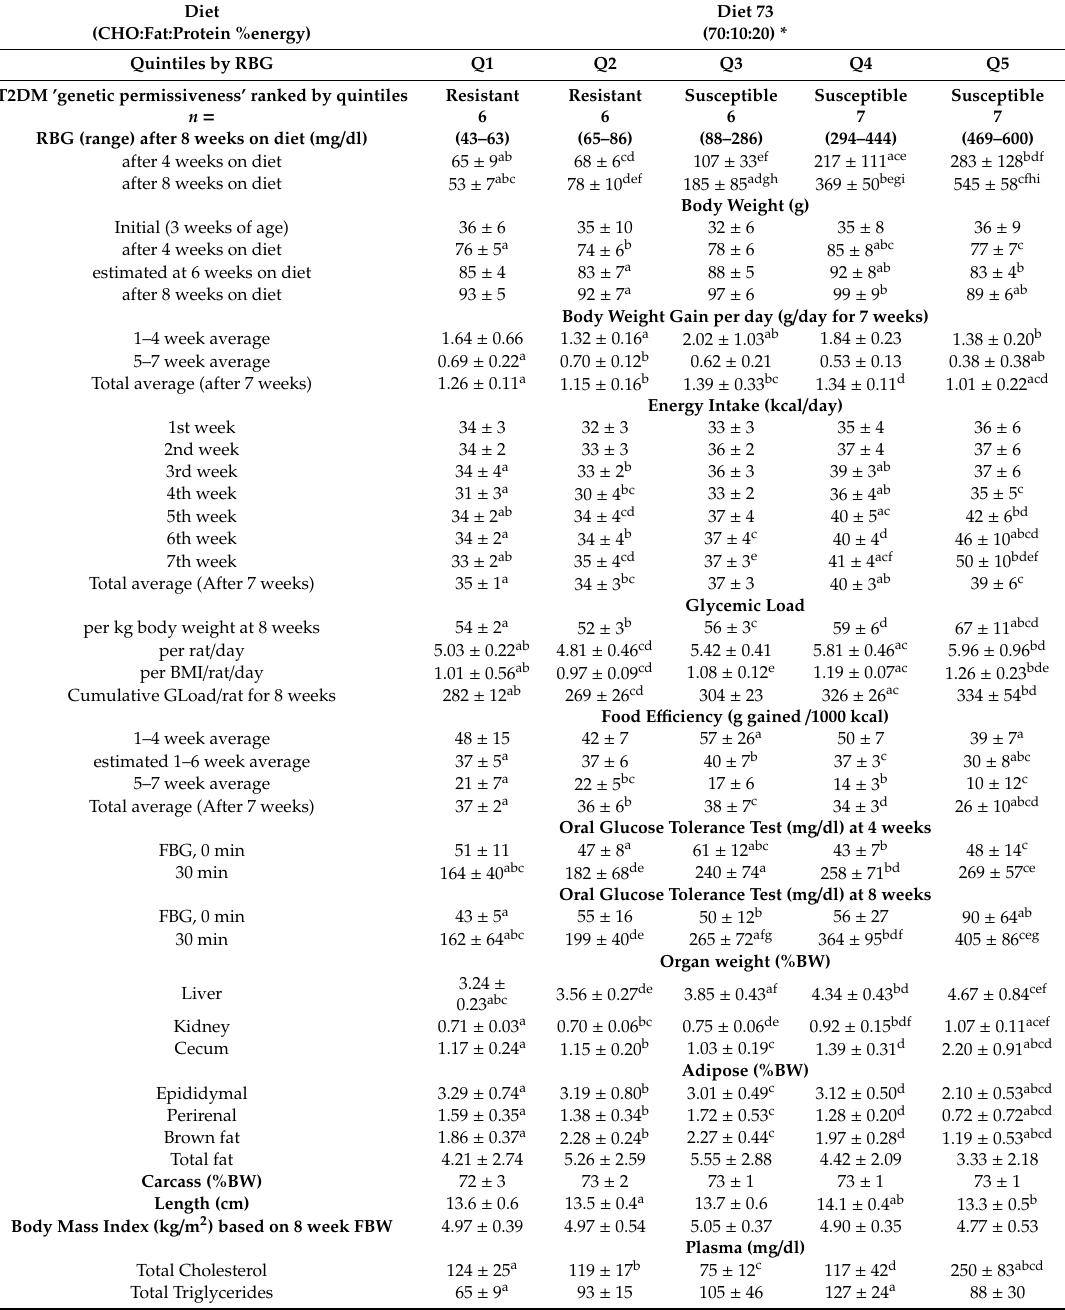
Table 5. (Experiment 3). Quintiles of RBG along with diabetes metagenetic profile for 32 male Nile Rats (3 weeks old) fed semipurified high CHO Diet 73 (70:10:20)* for 8 weeks, then subdivided into ’resistant’ or ’susceptible’ quintiles based on RBG < 75 mg / dl > , respectively (NR Studies 127, 128,